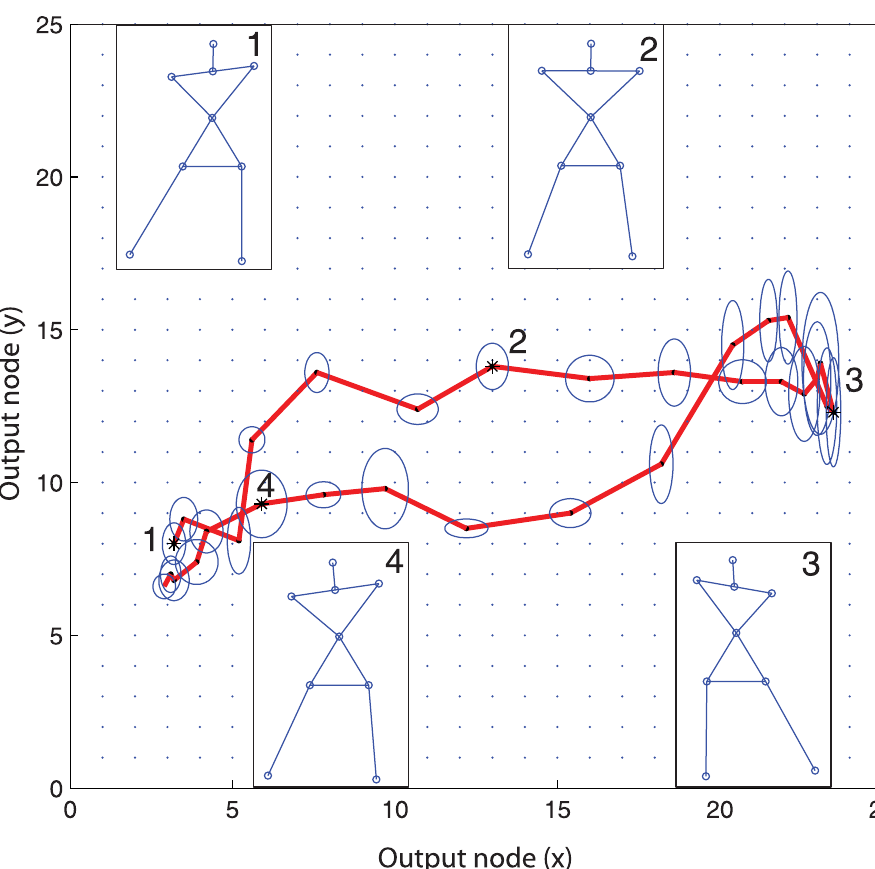
Fig 1. Average sway trajectory of a single subject on the trained SOM. The Best Matching Units (BMUs) of input posture vectors subsequently adopted during an exergame trial form a trajectory of BMUs on the output lattice of a SOM which is trained with movement data of all test subjects. The average sway trajectory of ten sway movements is shown for one older adult playing the ‘ maximum sway amplitude ’ -condition. Blue circles indicate the standard error of the mean for each BMU position. Stick figures are shown for illustration purposes and indicate the average adopted postures 1, 2, 3 and 4 captured at 1%, 25%, 50% and 80% of the time of the sway movement,